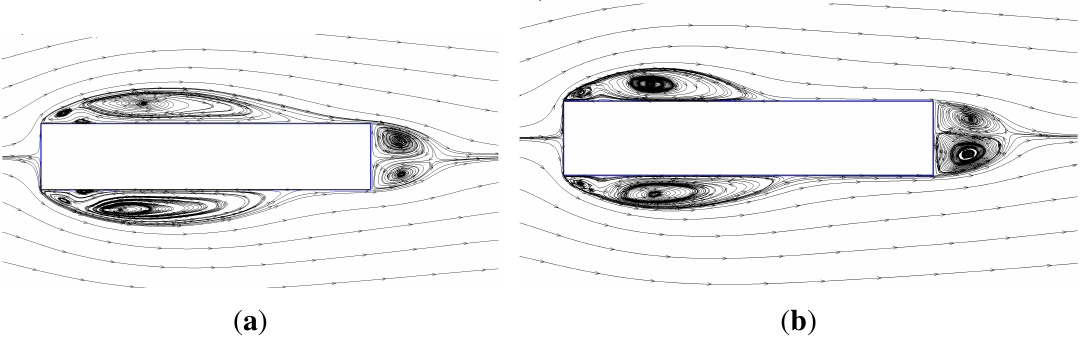
= 1 / 84 and ( b ) k = 1 / 256 . 4 4